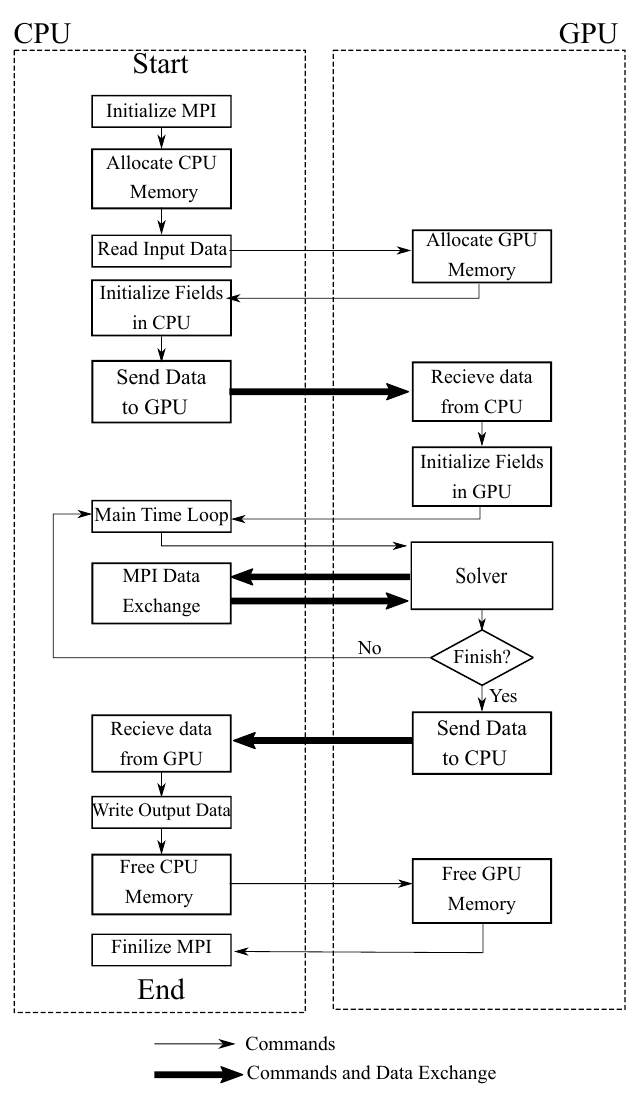
Figure 3. Working scheme for the GPU-using